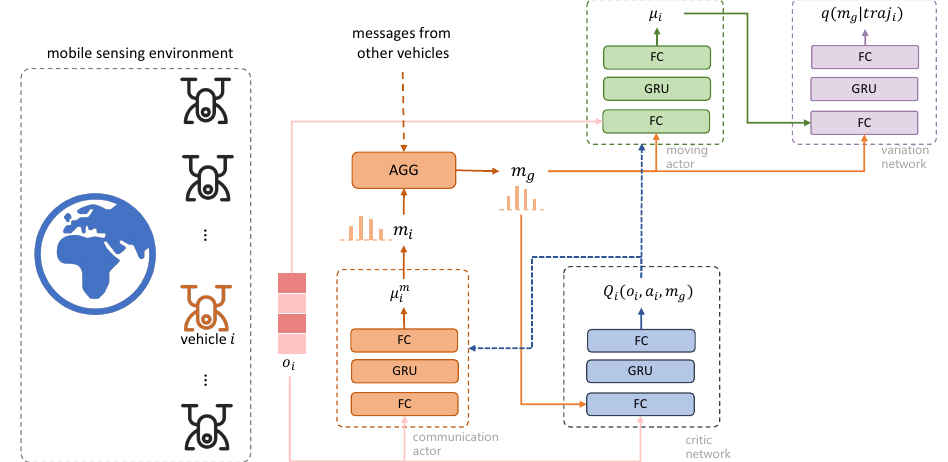
Figure 3. The network structure of policy coordination with consensual communication. FC repre- sents fully connected layer, and GRU represents gated recurrent unit layer. AGG is the aggregator operator for the received messages. According to the network structure, each mobile vehicle needs to maintain 4 networks: moving actor network (the green part), critic network (the blue part), communication actor network (the orange part) and the variation network (the purple part).